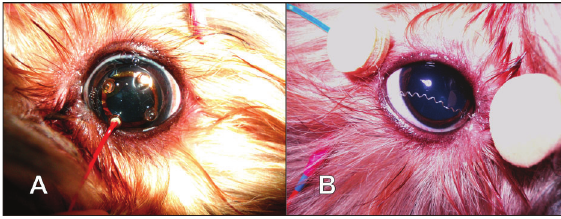
Figure 1. The electroretinogram (ERG) electrodes used in this study were positioned in the eye prior to the ERG procedure. A , ERG-Jet electrode (monopolar electrode). B , Fiber electrode prototype (monopolar